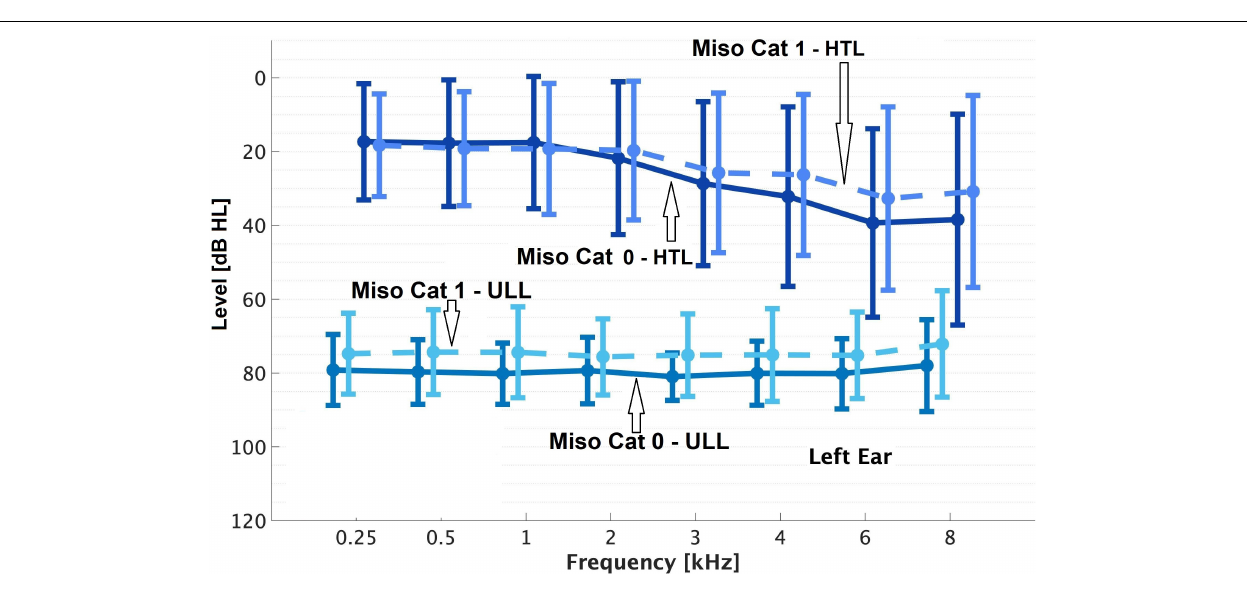
FIGURE 2 | As Figure 1 but for the left